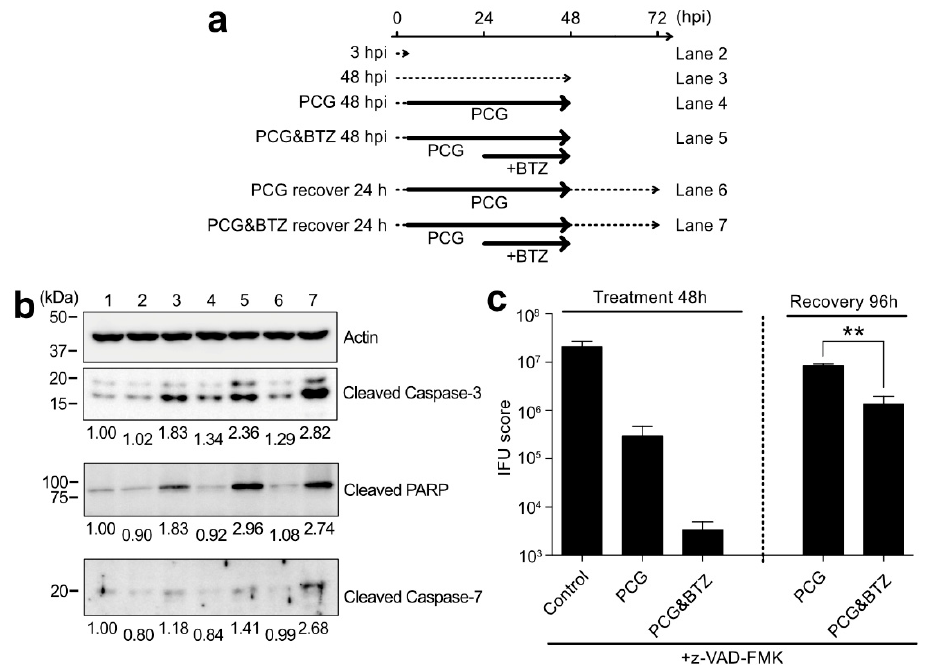
Figure 6. Short BTZ treatment specifically led to persistently Chlamydia -infected cell death through caspase activation. ( a ) Schematic of C. trachomatis L2 infection, time course of the chemical treat- ment/removal, and harvest period. ( b ) Each harvested cell sample was analyzed by blotting using a specific antibody. Each band densitometry was normalized with β -actin and defined lane 1 (no in- fection, time 0) as 1.00. ( c ) The infected cells were treated as described in Figure 5f with 10 μ M z- VAD-FMK. The IFU scores were calculated. Data are the mean ± SD of three independent wells. ** p < 0.01 compared to each control sample by Welch’s t -tests.